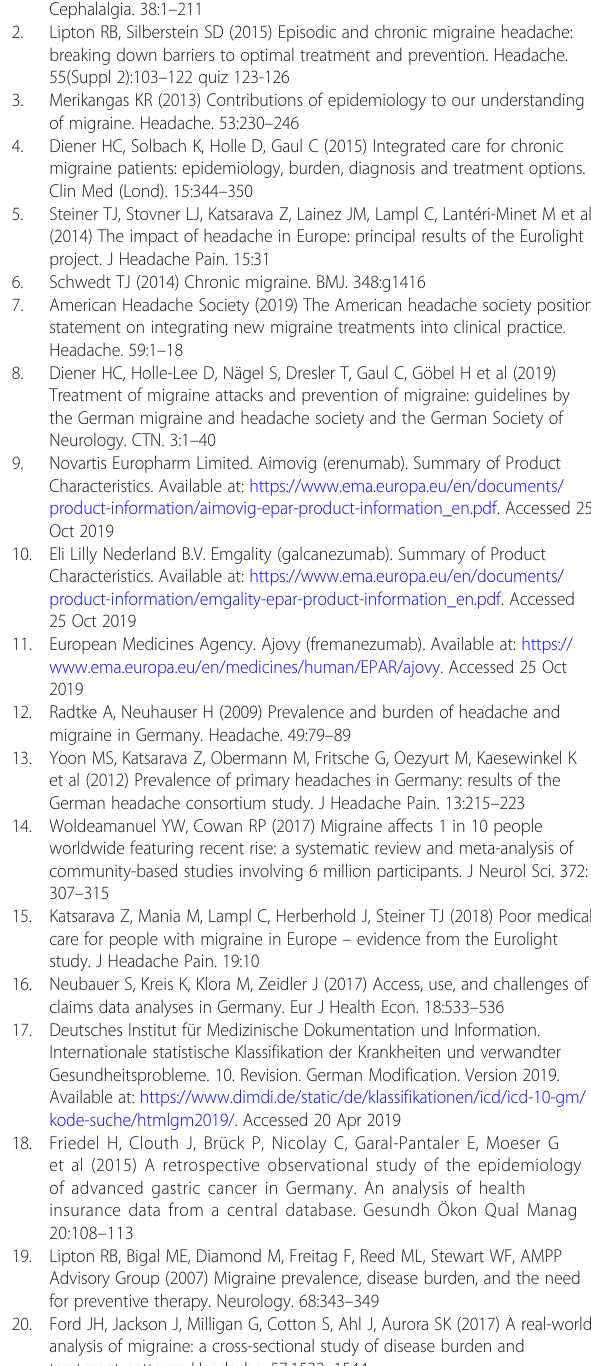
Additional file 2: Table S1. Summary of acute, emergency and prophylactic medications in the German Company Sickness Fund Database a Additional file 3: Table S2. Prescribed acute medications for patients who had been diagnosed with complicated migraine (G43.3, including chronic migraine) in the German Company Sickness Fund Database 2016 ( N =